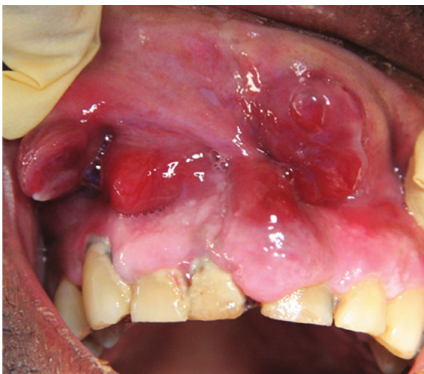
Figure 4: Exophytic oral HIV-KS lesions on the alveolar and labial mucosa in a 54-year-old male with a CD4+ Tcell count of 258cells/mm 3 . The patient died 15 weeks after his oral HIV-KS diagnosis.